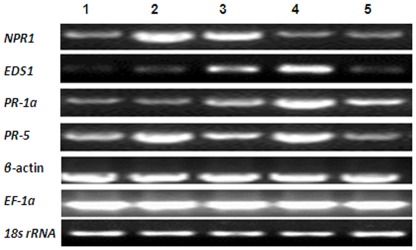
Gene expression analysis of crucial components of the SA signaling pathway by semi-quantitative RT-PCR.The genes encoding EDS1, NPR1, PR-1a and PR-5 were analyzed. Semi-quantitative RT-PCR was performed using gene-specific primers, and β-actin, EF-1a and 18S ribosomal RNA genes were selected as internal controls.